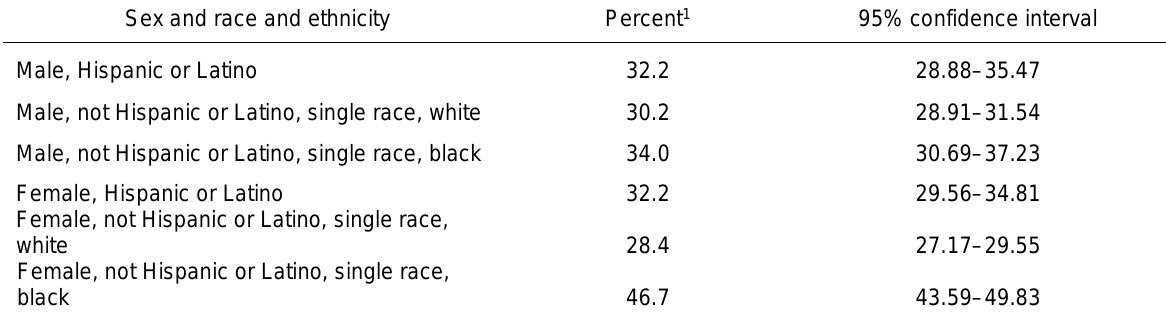
Data table for Figure 6.3. Age-adjusted prevalence of obesity among adults